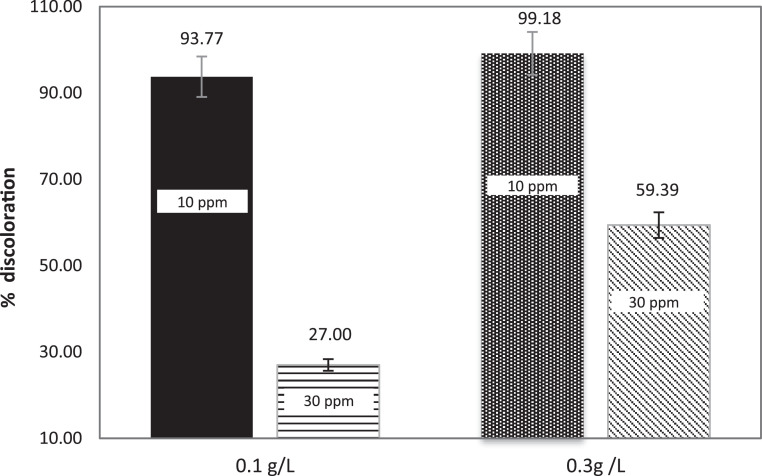
Comparison of MB discoloration by of TiO2/Fe3O4 (80/20) under natural solar test at pilot scale. [TiO2/Fe3O4] = 0.1 g/L and 0.3 g/L.